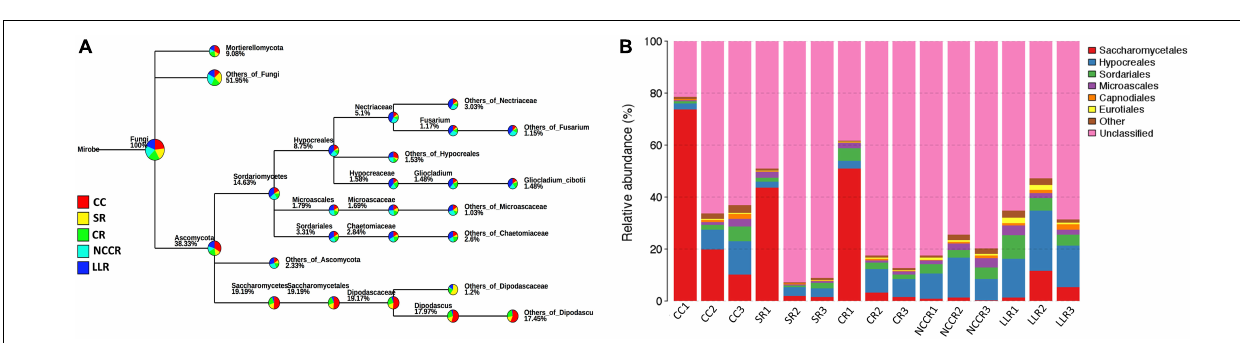
FIGURE 3 | Phylogenetic tree and histogram exposed the dominant soil fungal communities. (A) The phylogenetic tree classification represents the relative abundance of fungal microbiota at all levels in treatments. (B) Histogram revealed the relative abundance of the top fungal orders in all soil samples under different treatments. CC1-CC3 represents samples from continuous cucumber cropping; SR1, SR2, and SR3 from spinach rotation; CR1-CR3 indicates samples from coriander rotation; NCCR1-NCCR3 from non-heading Chinese cabbage rotation, and LLR1-LLR3 from leafy lettuce